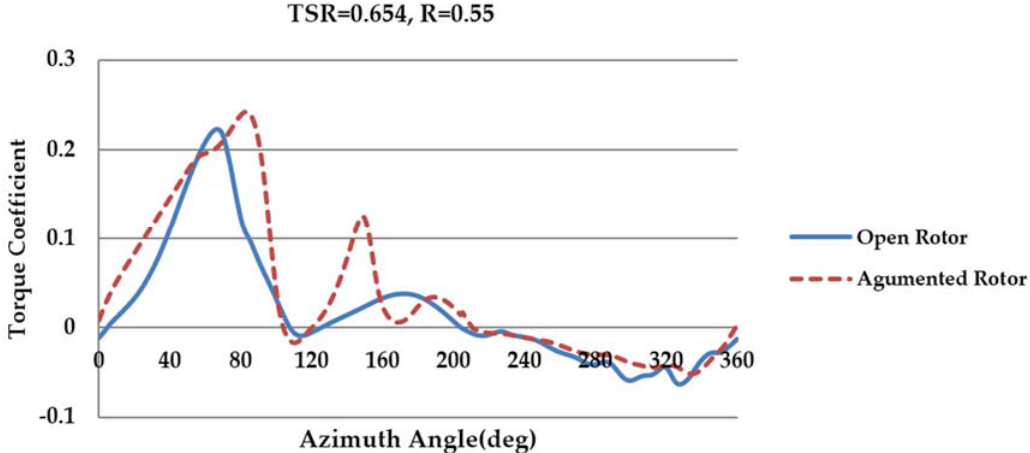
Figure 20. Torque coefficient versus azimuth angle for open and augmented rotor for TSR = 0.654, R shape ‐ ratio = 0.55.